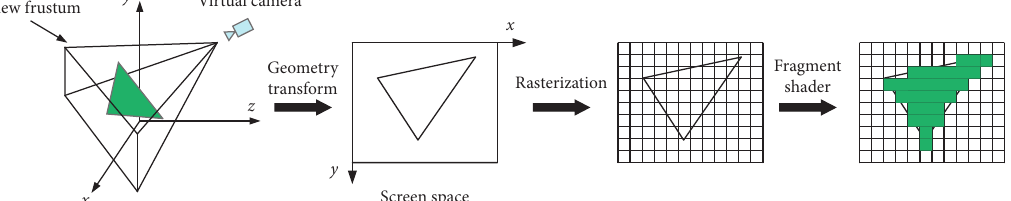
Figure 2: The process of rendering a triangle on the screen.